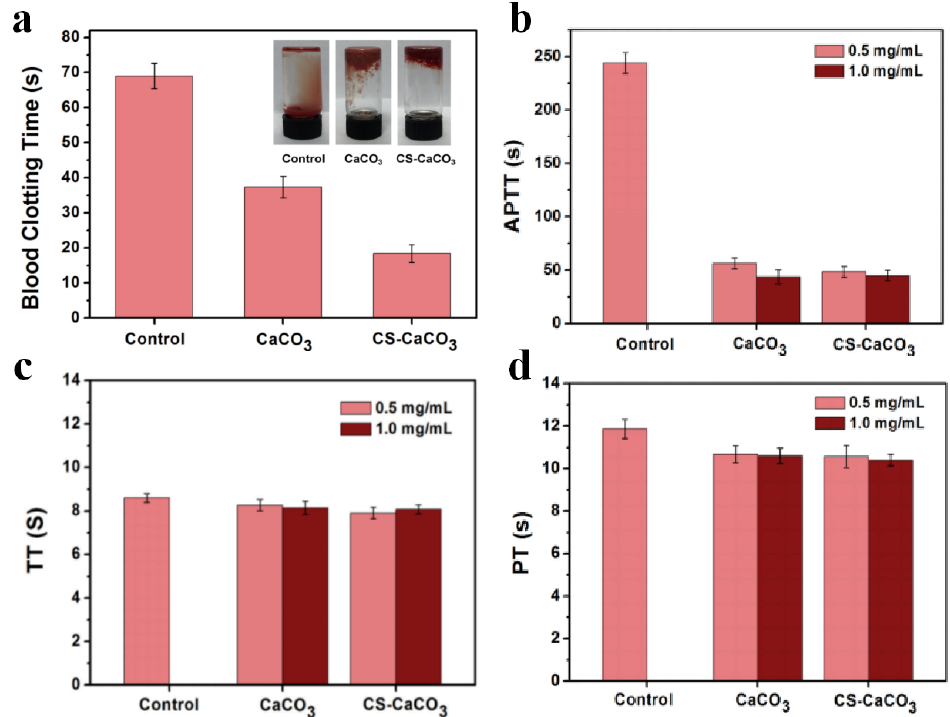
Figure 6. Blood coagulation test in vitro. ( a ) Blood clotting time, ( b ) aPTT, ( c ) TT and ( d ) PT measurement of CaCO 3 and CS – CaCO 3 .